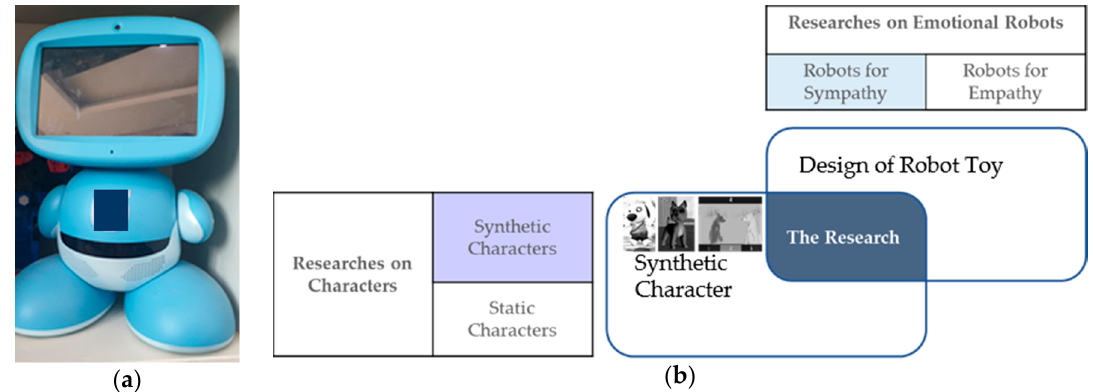
Figure 1. Synthetic character and robot: ( a ) robot toy abandoned; ( b ) target area/scope of the research.